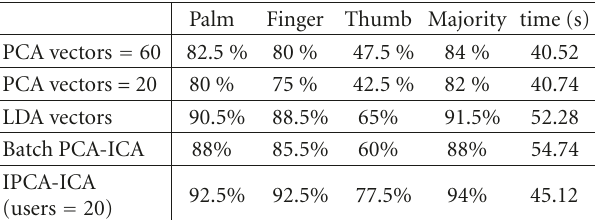
Table 1: Comparison between di ff erent algorithms.